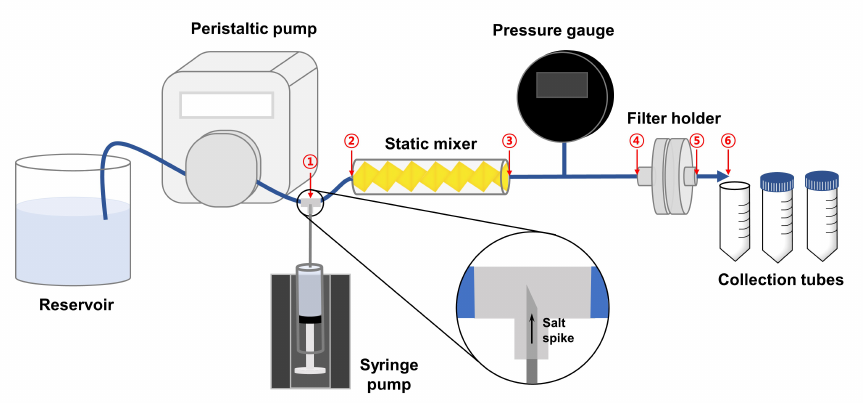
Figure 1. Schematic of the inline spiking system. The syringe needle penetrates the bottom of the tee to directly discharge the salt spike at the center of the feed stream. The circled numbers indicate the processing point to measure the holdup time.